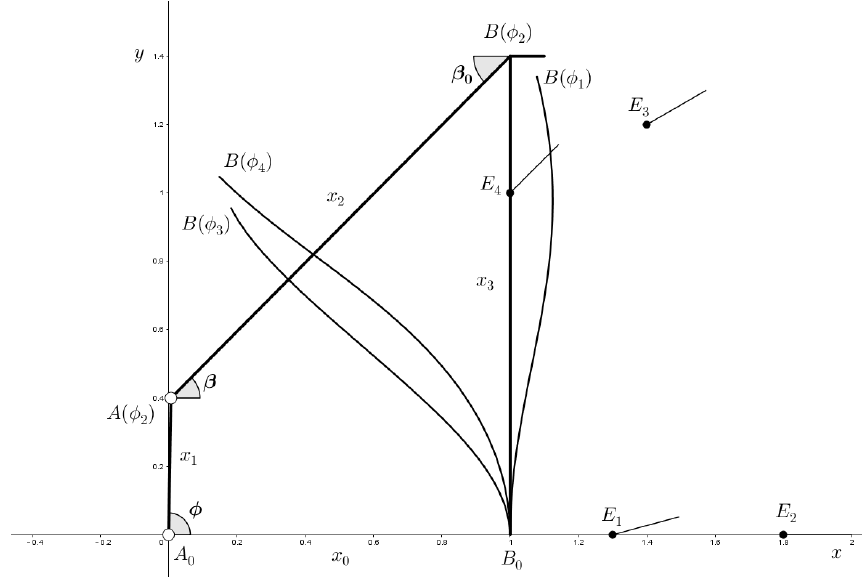
Figure 16. Function module and pole map.